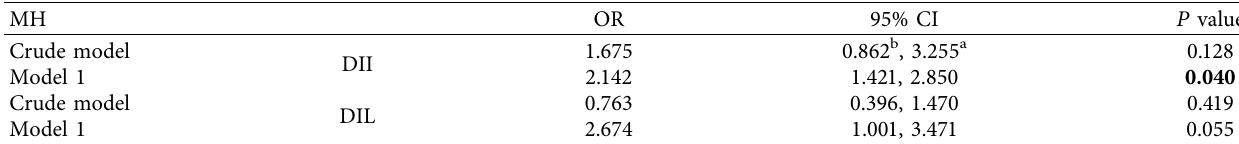
Table 4: Association of DII, DII and metabolically healthy, and metabolically unhealthy Obesity in overweight and obese women ( N � 228). MH OR 95% CI P value Crude model